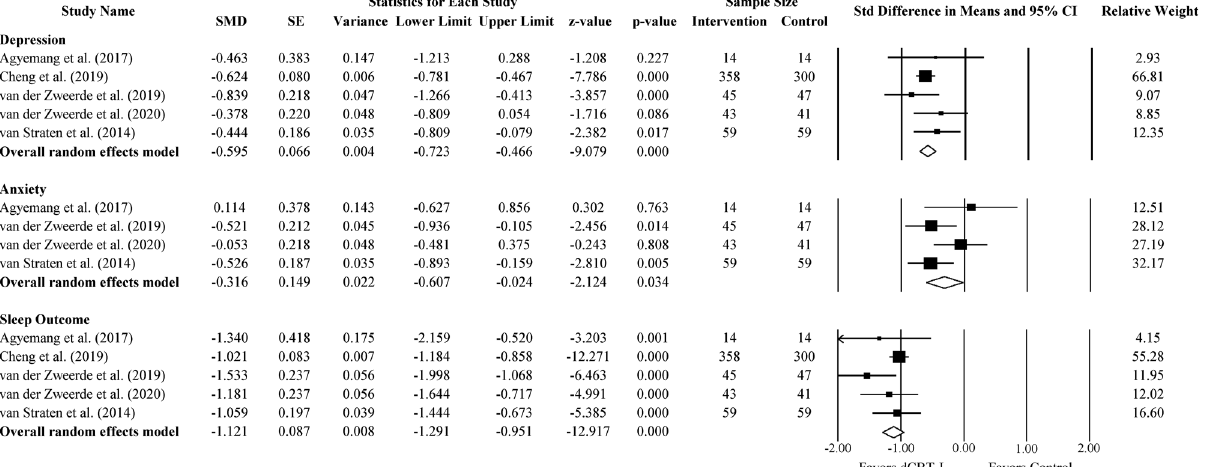
Fig. 5 The effect of dCBT-I among dCBT-I completers (>65%). Forest plot of studies reporting the effect of dCBT-I among dCBT-I completers with more than 65% of completion